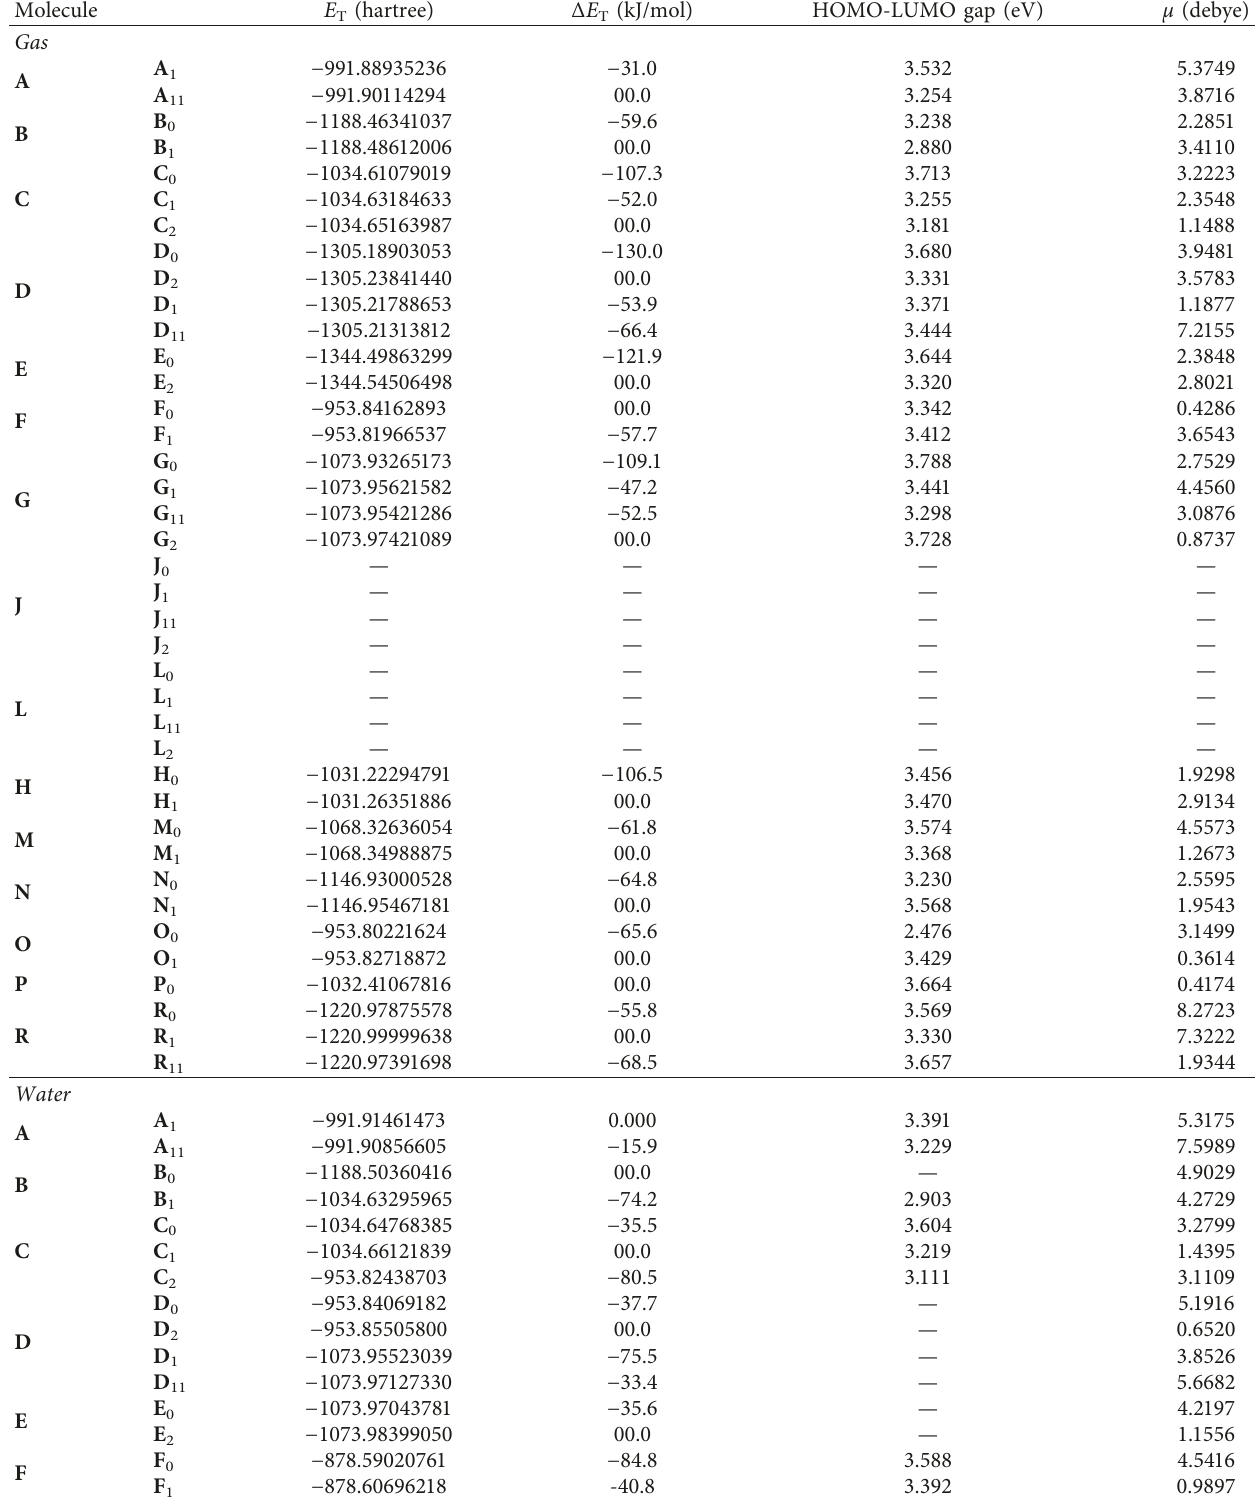
Table 3: Total energy (in hartree), relative total energy (kJ/mol), HOMO-LUMO gap (eV), and dipole moment (in debye) calculated at B3LYP/6-311++G(d,p) level in vacuum and